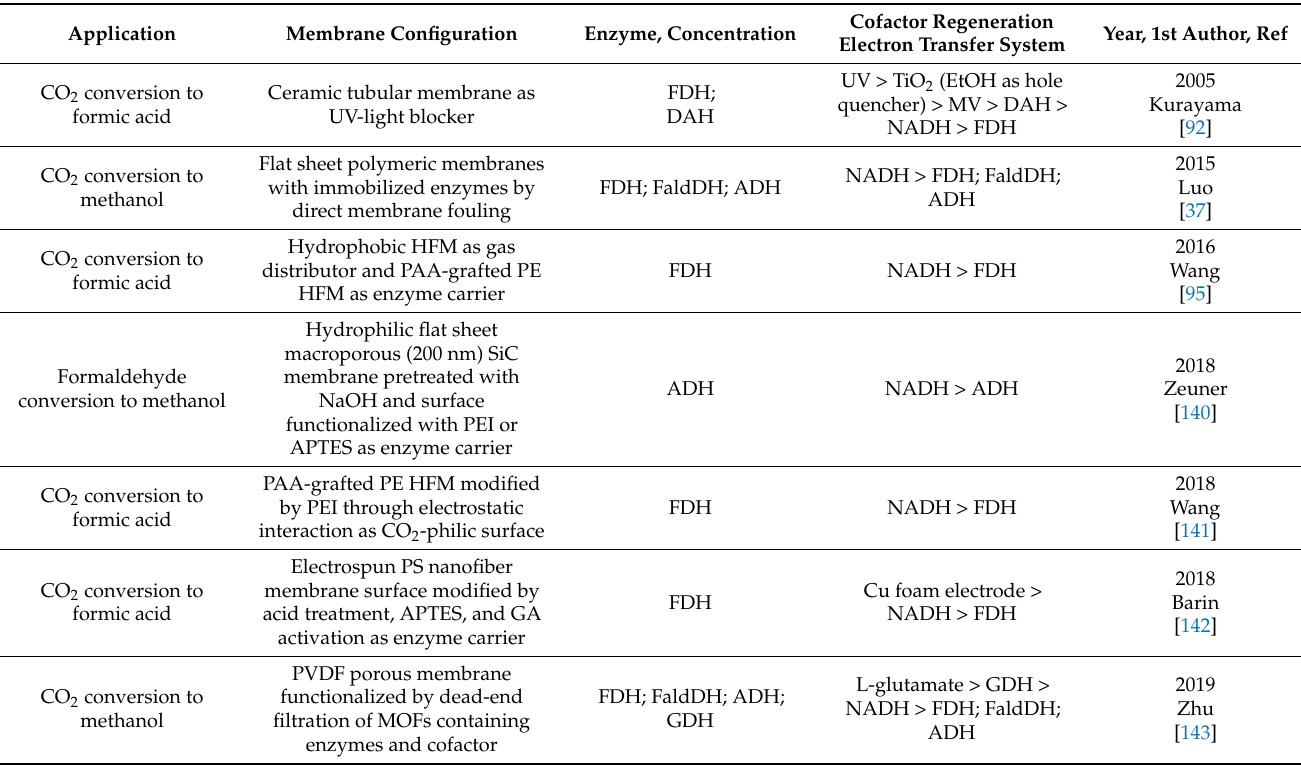
Table 4. CO 2 conversion to chemicals with